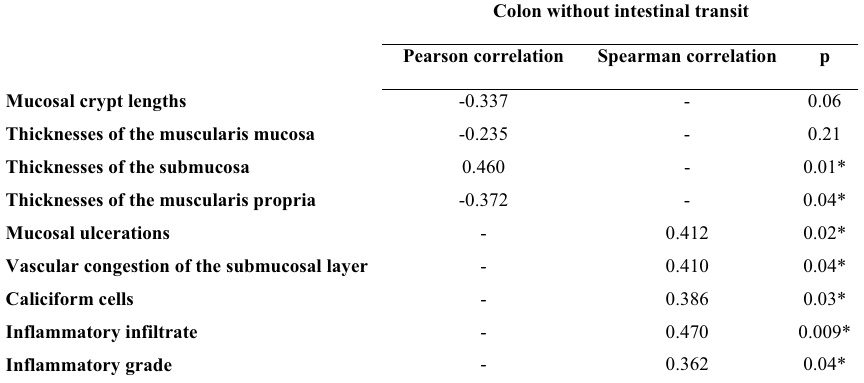
TABLE 1 - Correlations between the studied variables and the length of time without transit in the colon segments without fecal